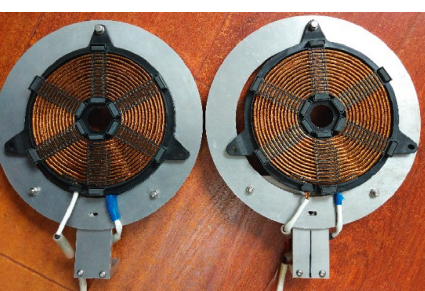
Figure 13: Receiving coil and launch coil of the practical MCRETS